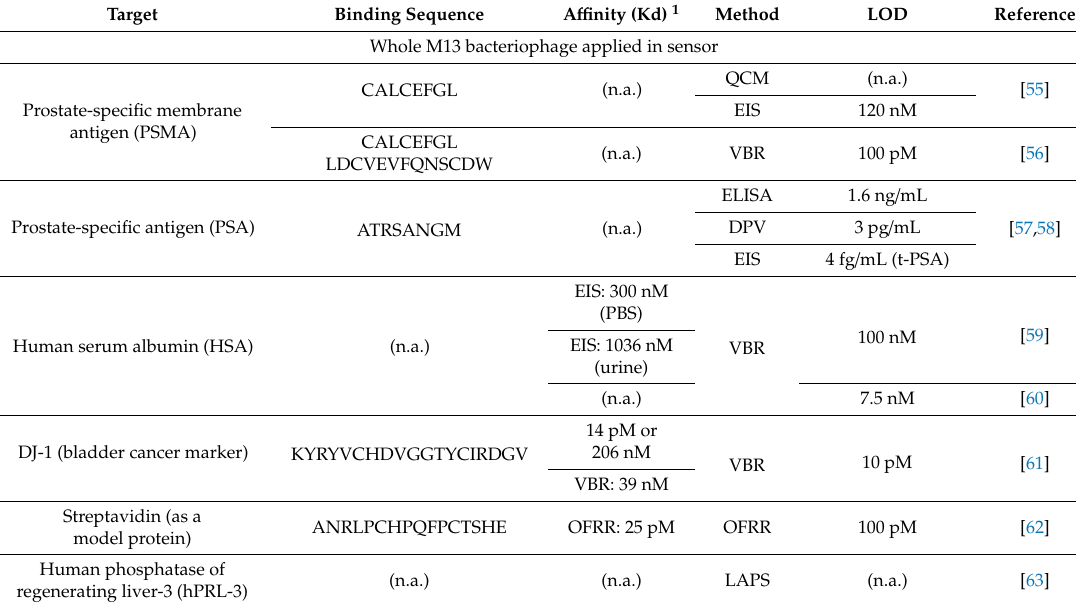
Table 1. Comparison of the bacteriophage-based and peptide-based sensors. Binding sequences do not include functionalizations of peptides such as cysteine or